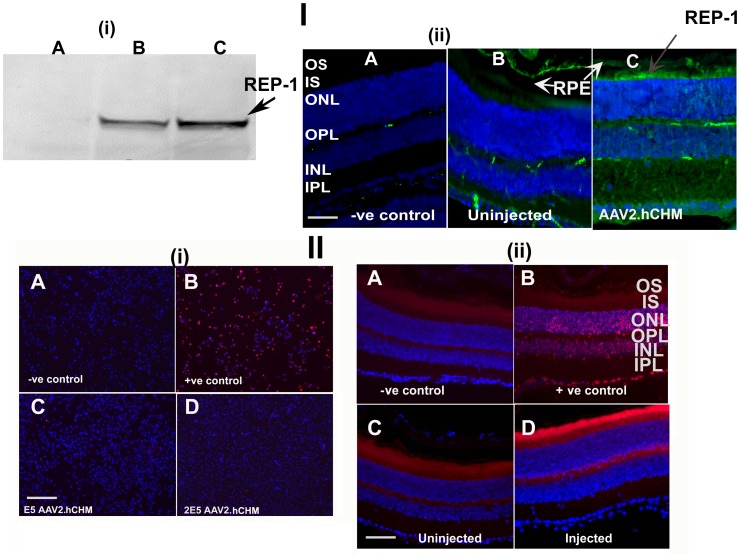
Infection of wild type mouse retinas with AAV2.
hCHM results in transduction of retinal cells and appears safe. I). Western blot analysis of retinas of normal sighted control mice injected subretinally with 3E6 vg AAV2. hCHM shows one single expected size band in different animals (B, C) (i). A. Uninjected control. Immunolabeling of the AAV2. hCHM-injected retinas (I-ii) shows the localization of the REP-1 protein (Green) to photoreceptors and retinal pigment epithelium (I-ii-C). Nuclei are stained with DAPI. A- negative control, B-uninjected control retina. RPE: Retinal pigment epithelium; OS: Outer segments; IS: Inner segments; ONL: Outer nuclear layer; OPL: Outer plexiform layer; INL: Inner nuclear layer; IPL: Inner plexiform layer. II). TUNEL staining of CHO cells (II-i) and retinal sections (II-ii) from retinas injected with AAV2. hCHM in comparison to control uninjected tissue (II). A: CHO cells were infected with E5 (II-i-C), and 2E5 (II-i-D) vg/ml of AAV2. hCHM to evaluate the cytotoxicity of the virus. There were few apoptotic nuclei 72 h after transduction, showing that infection did not result in acute cell death. There was no increase in TUNEL-positivity in AAV2. hCHM injected retinas (II-ii-D). Uninjected (II-ii-C) and injected retina appear similar (II-ii-D).Autofluorescence (red color) is observed in photoreceptor outer segments in all panels. Nuclei are stained with DAPI. Negative controls were generated by incubating the tissue with TUNEL reagents alone (i–A; ii–A). DNAse I treated cells or retinal sections were used as positive controls (i–B; ii–B).